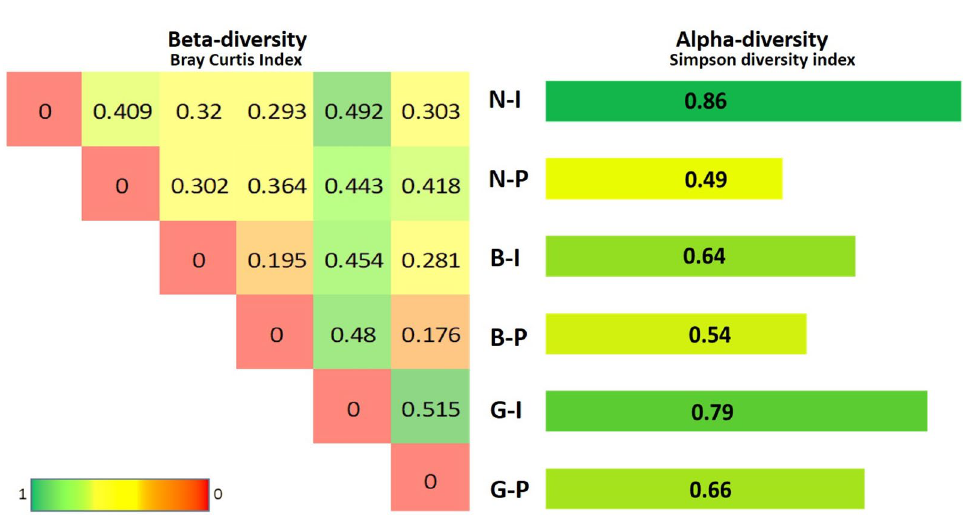
Figure 2. Alpha and beta-diversity of identified bacterial communities are estimated according to the Simpson diversity index and Bray Curtis, respectively. The three locations (N, G, and B) from two different sources, the inflow- (I) and pond-water (P), are